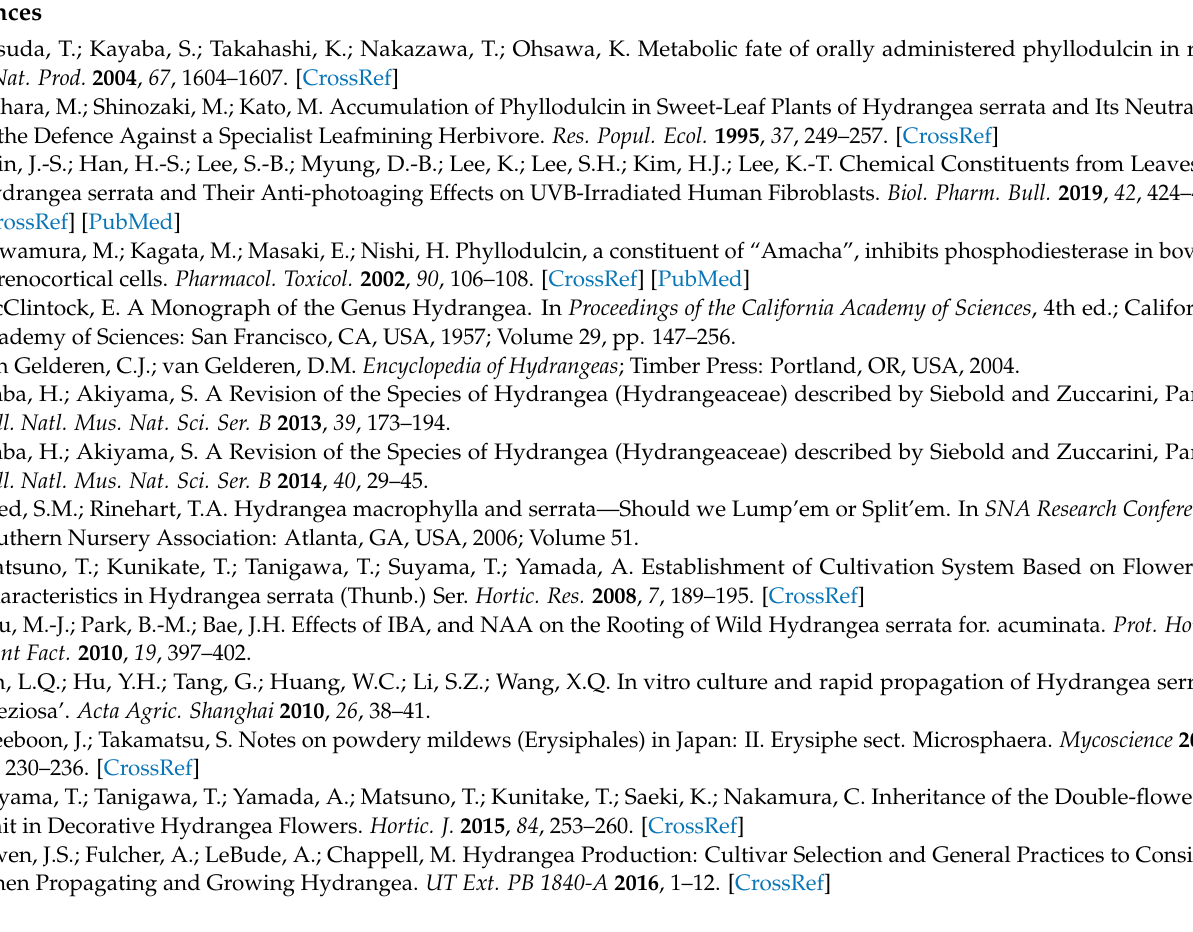
tables; Table S7: multivariate analysis for year 2018; Table S8: Detailed ANOVA for year